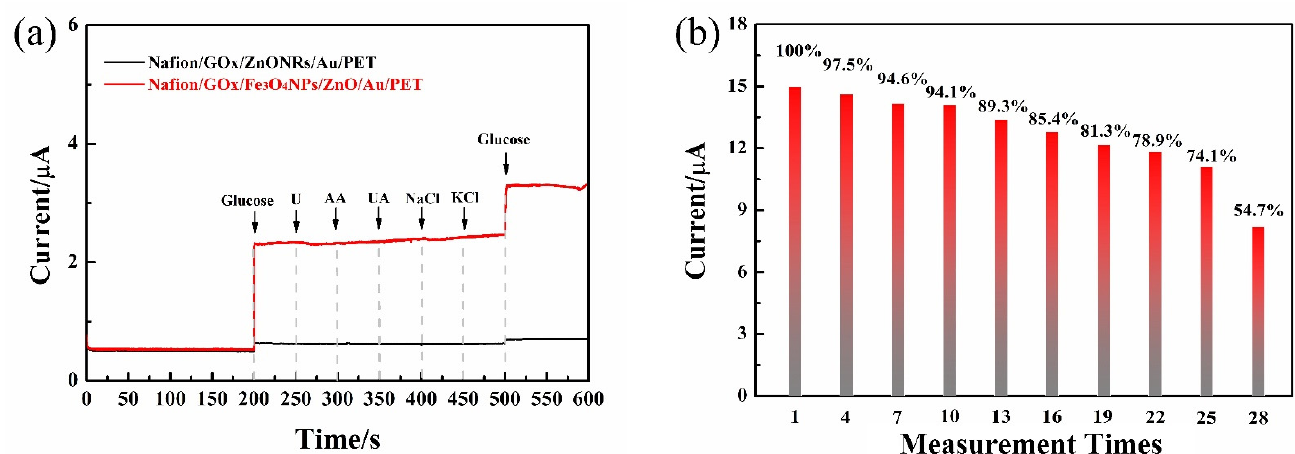
Figure 7. ( a ) The anti-interference of the as-fabricated glucose sensors. ( b ) The service life of Nafion/GOx/Fe 3 O 4 MNPs/ZnONFs/Au/PET glucose sensors.